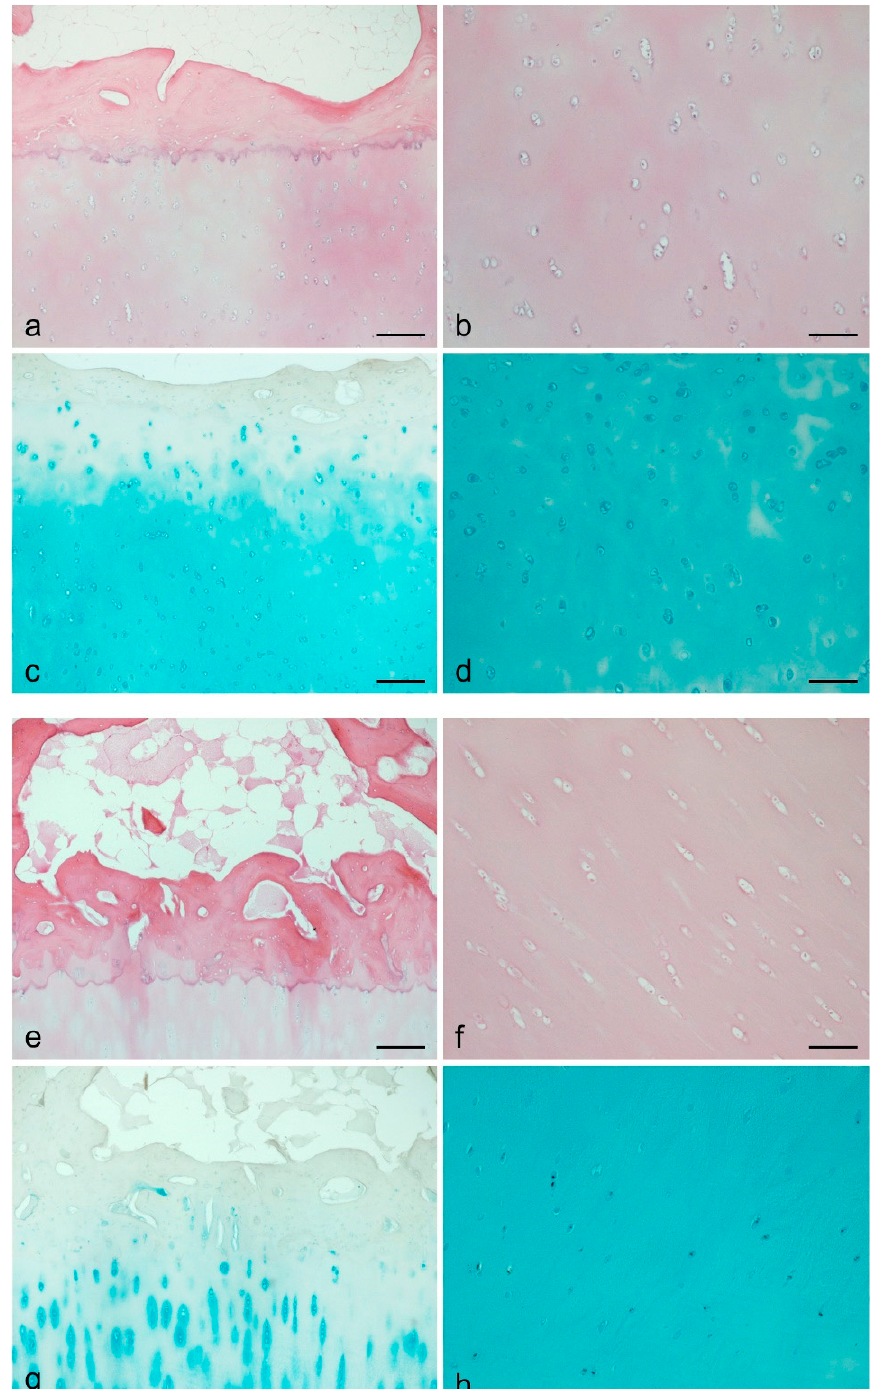
Figure 2. Histological morphology of humeral ( a – d ) and patellar ( e – h ) articular cartilage after hematoxylin and eosin ( a , b , e , f ) staining. In parallel, acidic polysaccharides (i.e., glycosaminoglycans) were stained by Alcian blue ( c , d , g , h ) in both samples. Scale bar: ( a , c , e , g ) 200 µm; ( b , d , f , h ) 100 µm.